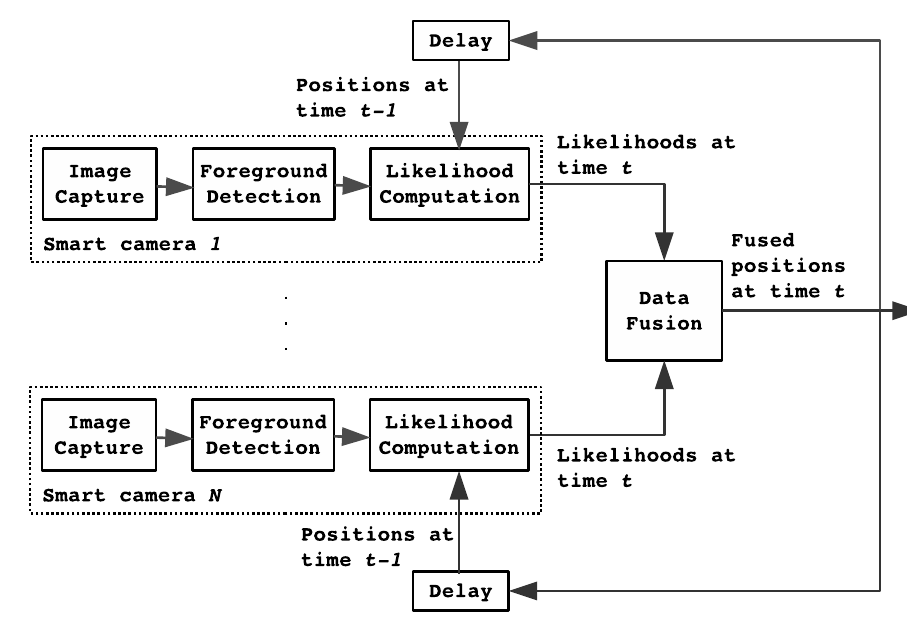
Figure 3. System architecture of our proposed